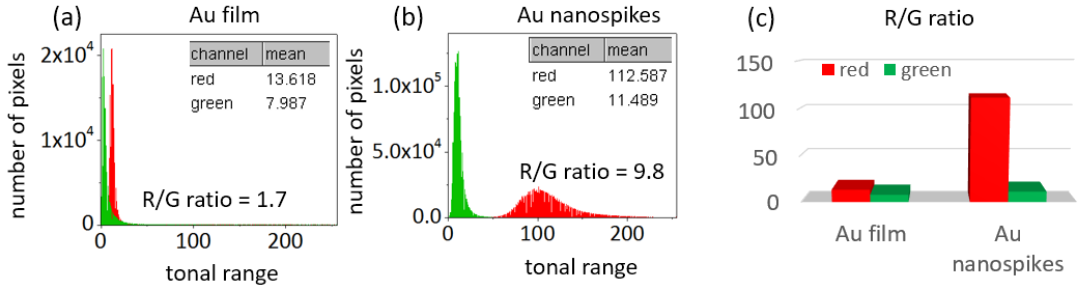
Figure 8. ( a , b )—color histograms, acquired from the microphotographs in Figure 3; ( c )—red to green (R / G) ratios of photographs with the Au film and Au nanospikes.